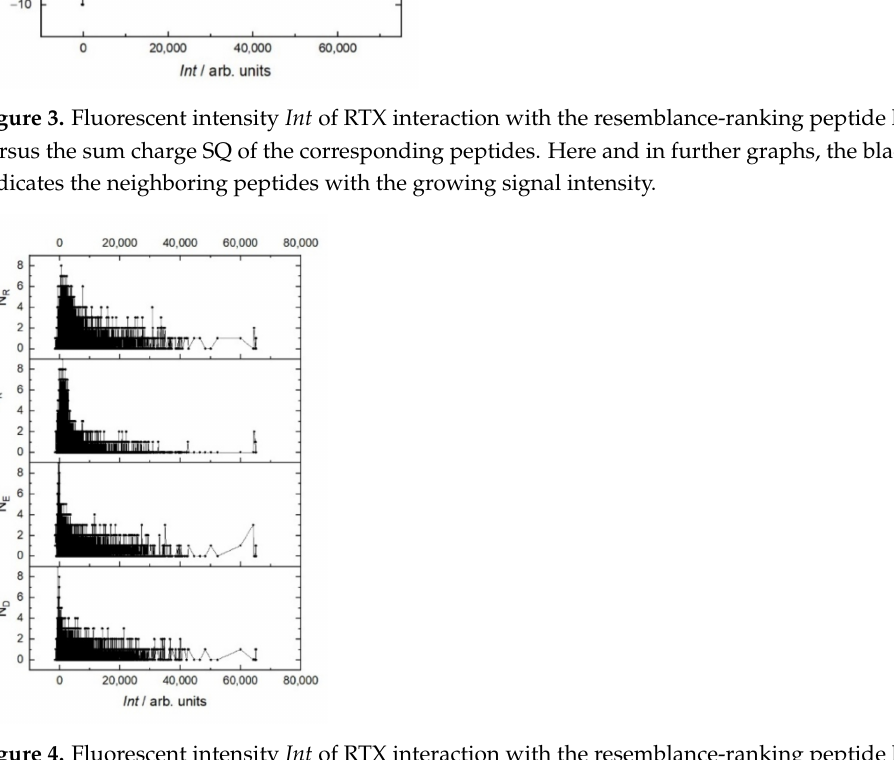
Figure 4. Fluorescent intensity Int of RTX interaction with the resemblance-ranking peptide library versus the number N of positively charged amino acids R and K and negatively charged amino acids E and D of the corresponding